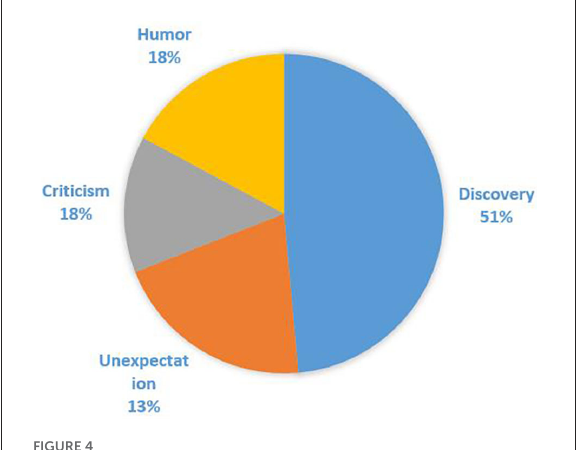
FIGURE4 Distribution of